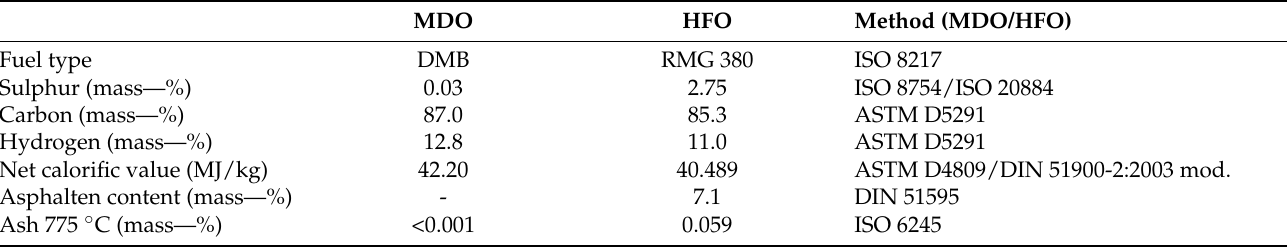
Table 1. Main fuel properties according to